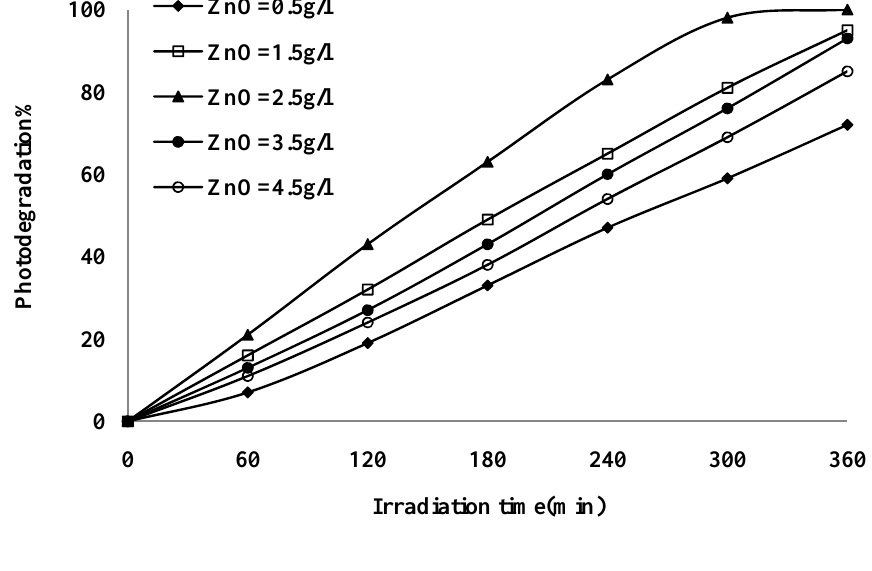
Figure 2. Effect of photocatalyst loading on photodegradation of p -cresol under UV, initial condition: p -cresol concentration = 100 ppm and pH =